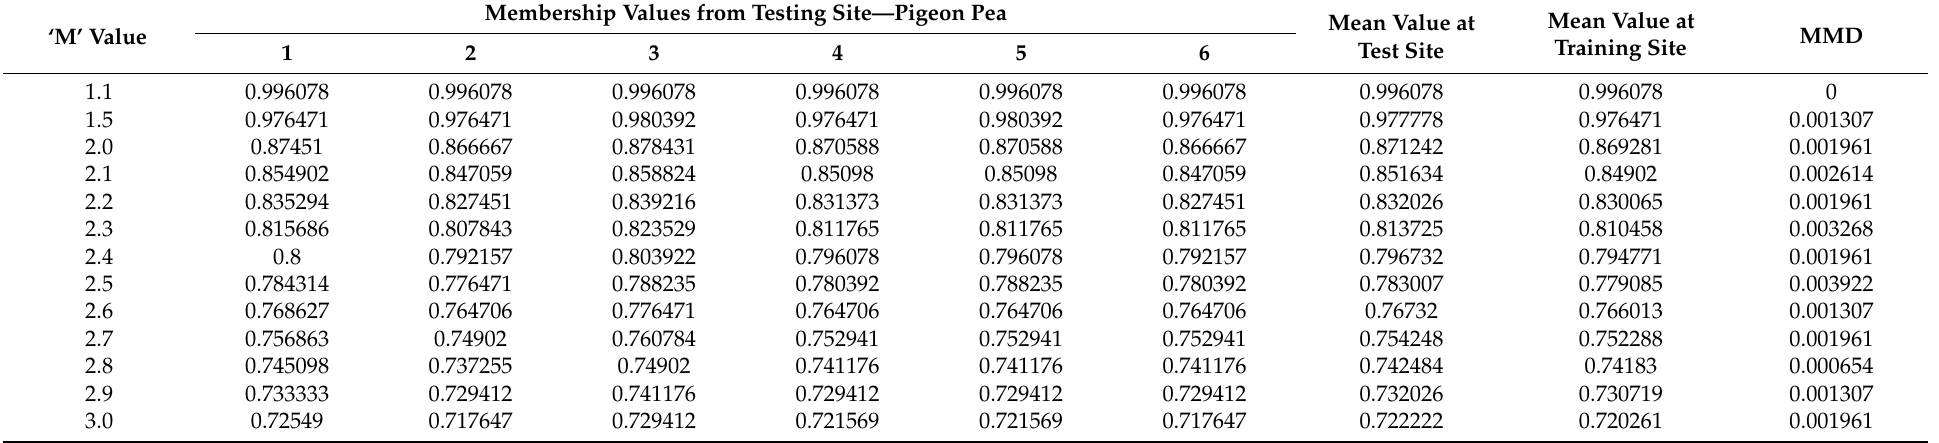
Table 6. Varying ‘m’ values with MMD exhibiting Proximity of Pigeon Pea Training Fields to the Pigeon Pea Test Fields—ISM training parameter based PCM classifier. Membership Values from Testing Site—Pigeon ‘M’ Value